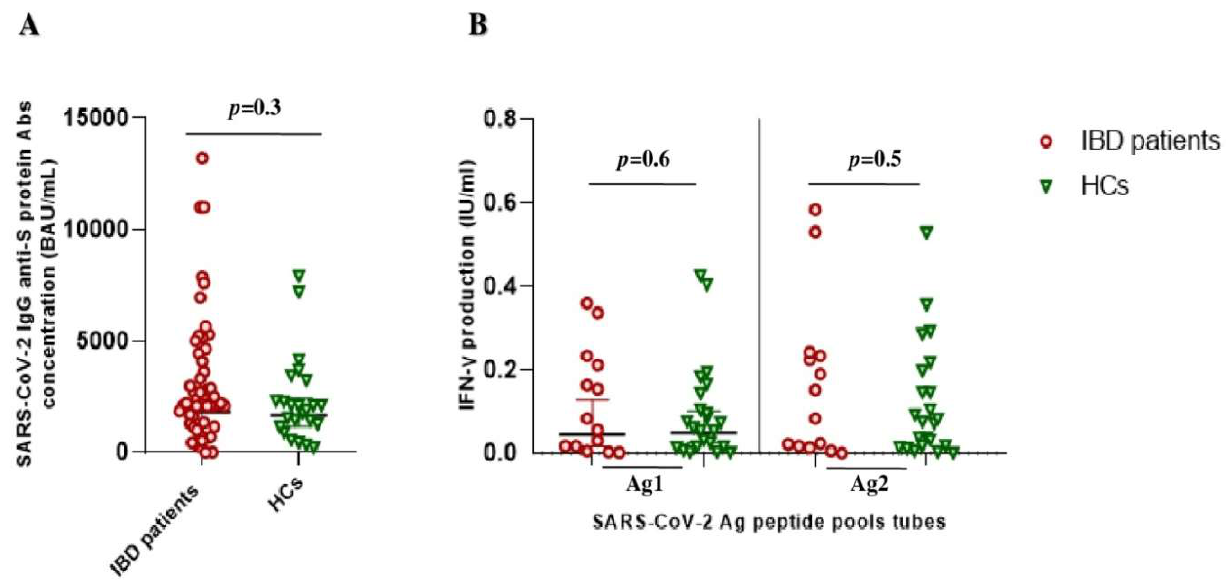
Figure 1. SARS-CoV-2 vaccine-elicited adaptive immune response after booster shot in IBD patients and healthy controls (HCs). ( A ) Anti-SARS-CoV-2 trimeric S protein antibodies (Abs) concentration (BAU/mL) between the IBD patients (red circles) and HCs (green triangles) groups. ( B ) QuantiFERON SARS-CoV-2 antigen tubes (Ag1 and Ag2) response, express as IFN- γ production (IU/mL), among the IBD patients (red circle) and HCs (green triangle)